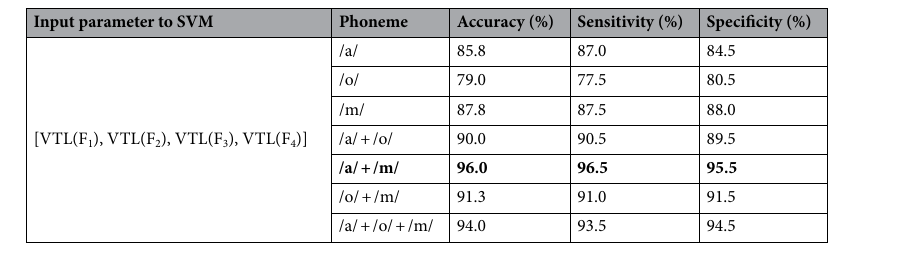
Table 5. The SVM classification results of Viswanathan’s database. Significant values are in